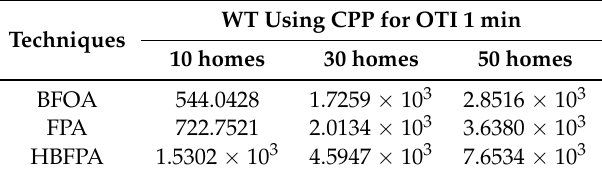
Table 13. Waiting time for 24 h (for multiple